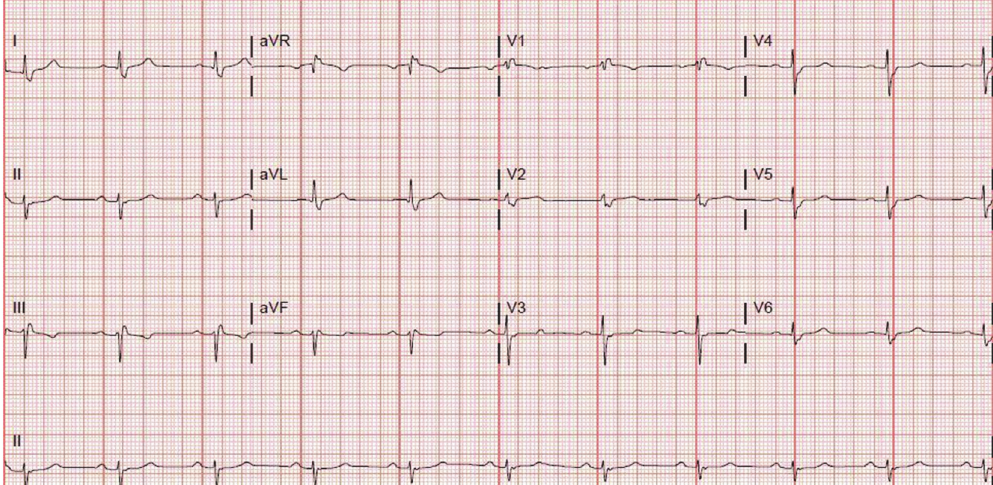
Figure 1: EKG showing borderline AV conduction delay and right bundle branch block (RBBB) pattern.